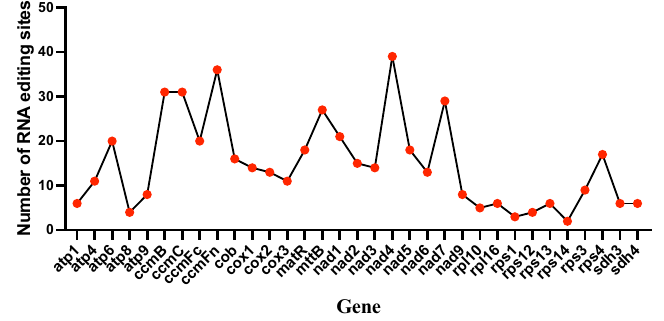
Figure 7. The distribution of RNA-editing sites in the P. serratifolia mitochondrial protein-coding